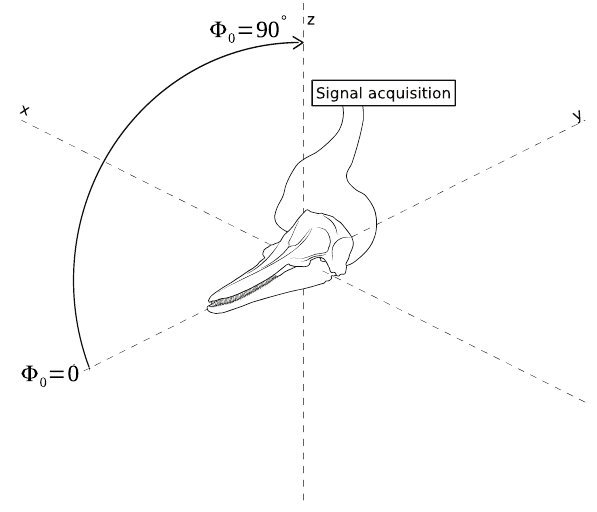
Figure 5. Simulation con fi guration. The solid curve marks the range of elevation of the sources. From each elevation, a plane wave is